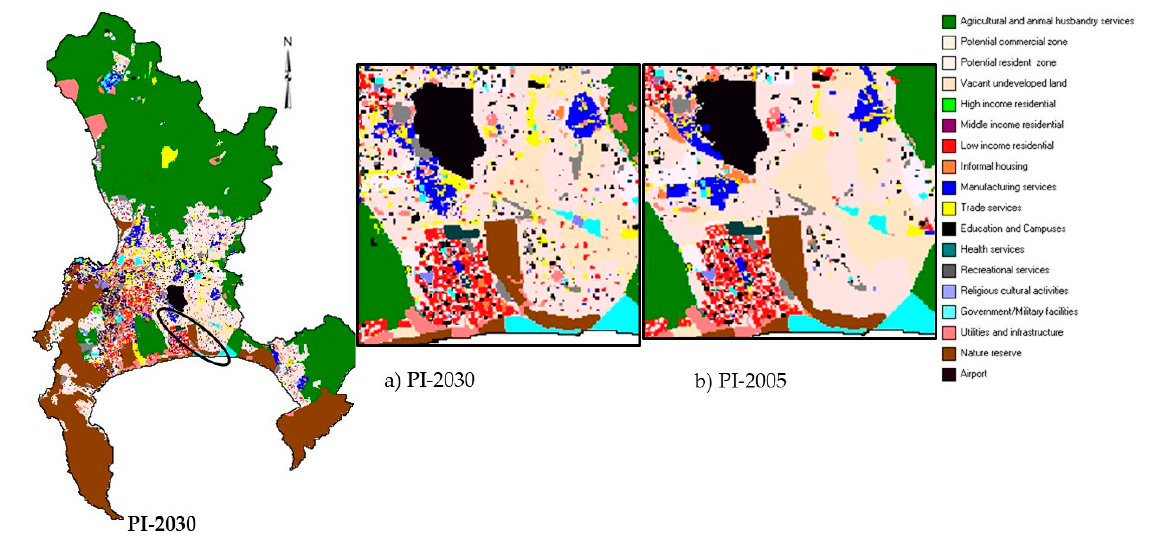
Figure 7. Metro South East Integration Zone; ( a ) MSEIZ under the PI-2030 scenario; ( b ) MSEIZ in 2005.